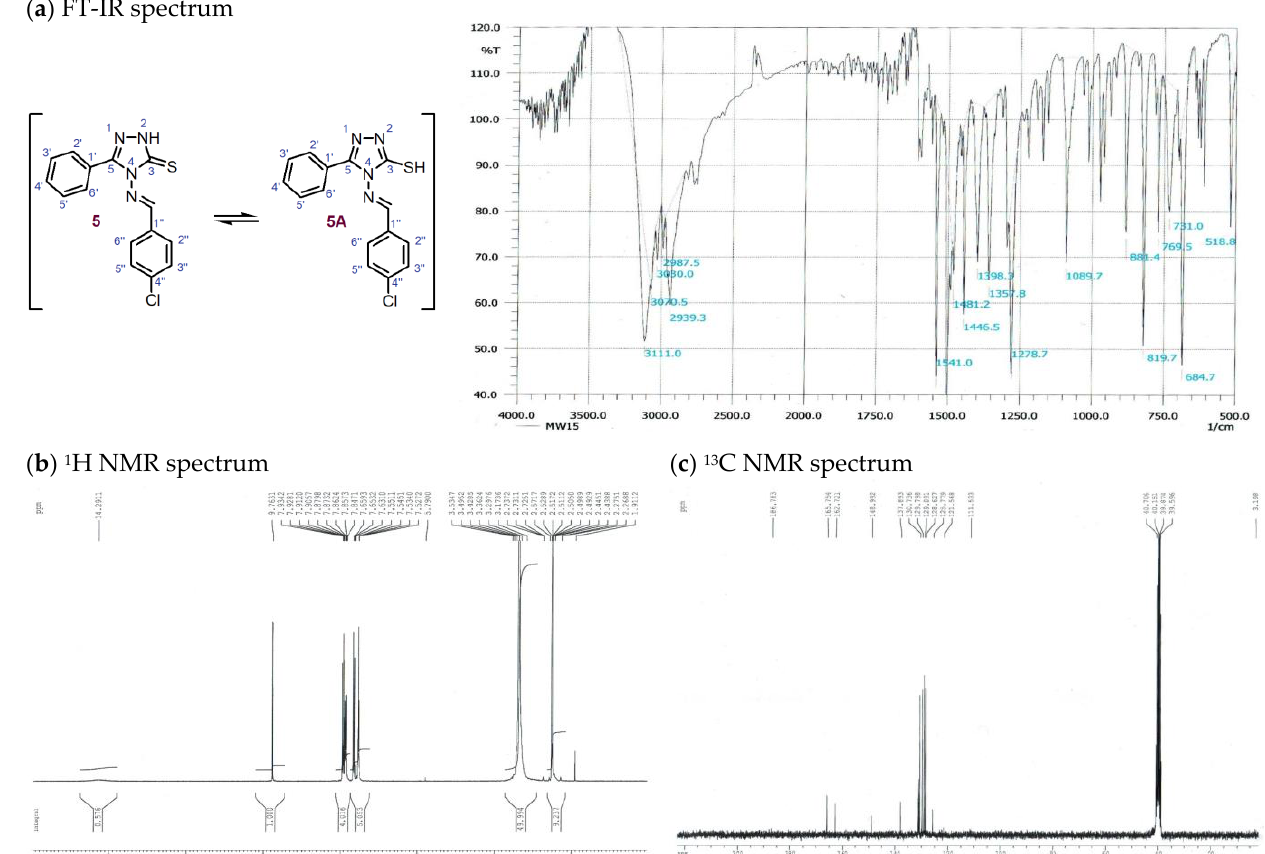
Figure 3. Spectroscopic characterization for the Schiff base 5 .